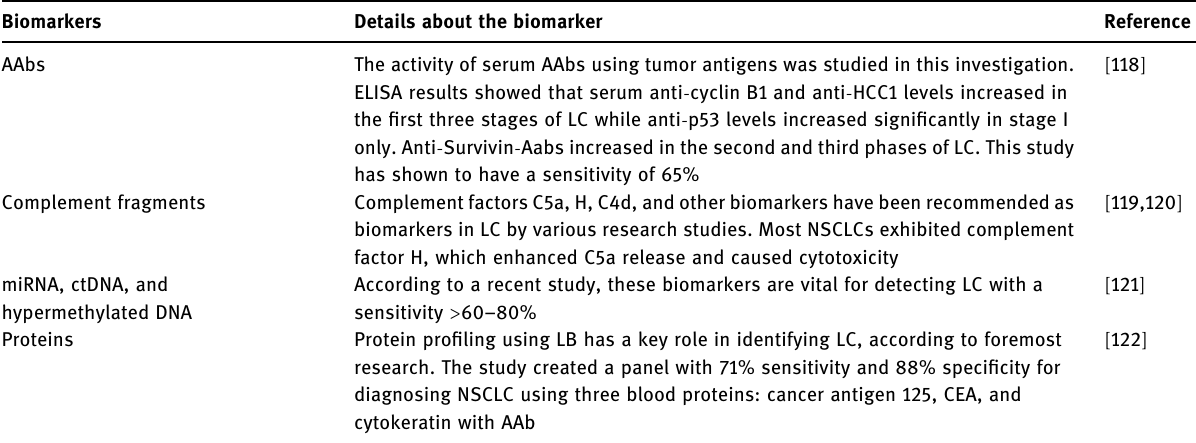
Table 3: Various widely used biomarkers [ 10 ]